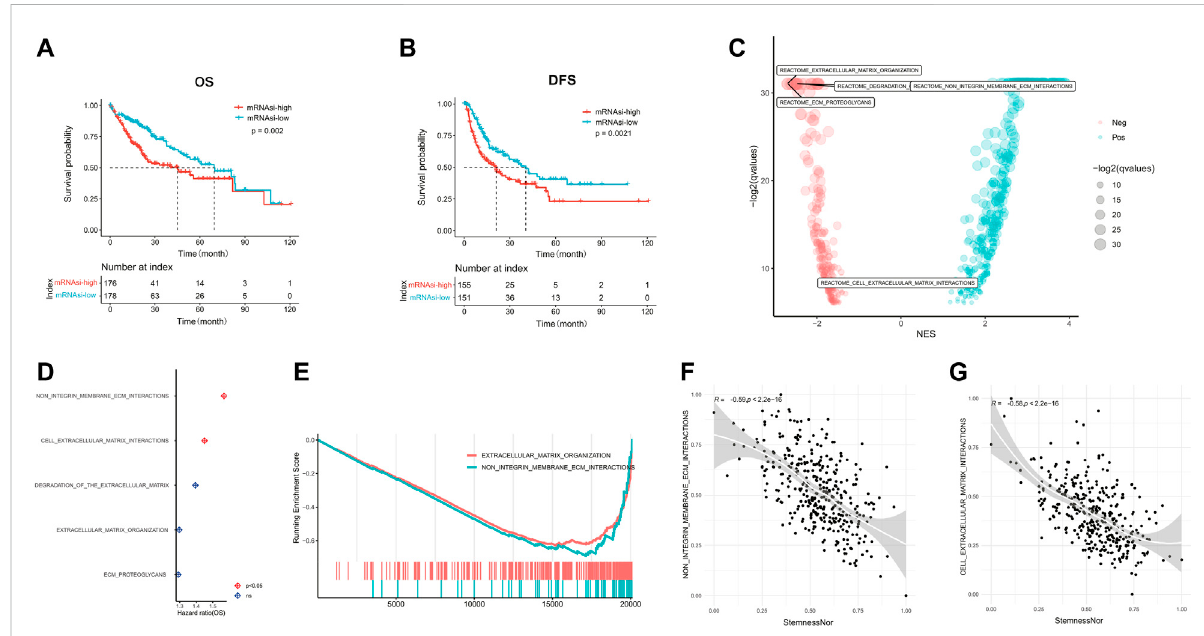
FIGURE 1 linical characteristics of stemness in HCC. The Kaplan – Meier plots illustrate the (A) overall survival and (B) disease-free survival in the high mRNAsi group compared with the low mRNAsi group. (C) Signi fi cantly enriched pathways of differentially expressed genes between high and low mRNAsi groups. The locations of ECM-related pathways are indicated. (D) Correlation analysis of ECM-related pathways and prognosis of HCC. (E) GSEA analysis of differentially expressed genes between high and low mRNAsi groups. (F) Correlation of the non-integrin membrane – ECM interaction pathway with the mRNAsi score. (G) Correlation of the cell – extracellular matrix interaction pathway with the mRNAsi score. HCC, hepatocellular carcinoma; mRNAsi, mRNA expression – based stemness index; ECM, extracellular matrix; GSEA, Gene Set Enrichment